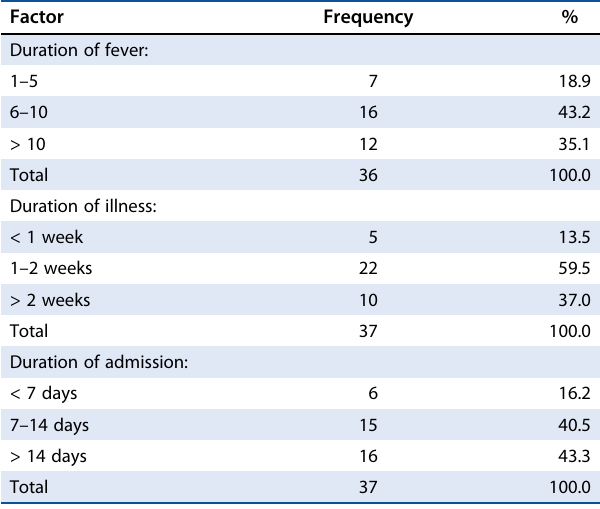
Table 3: Duration of fever, illness before presentation and total duration of admission of cases with typhoid ileal perforation Factor